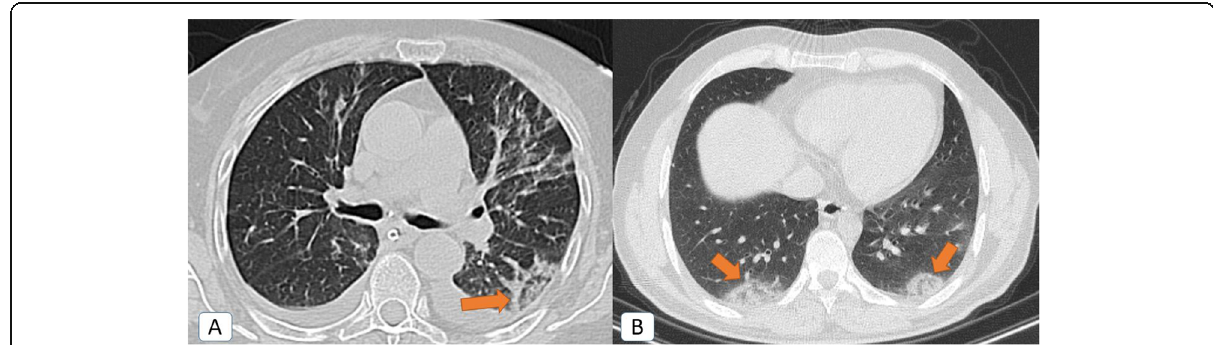
Fig. 6 Bulls-eye sign or target sign or double-halo sign: a 36-year-old male COVID-19 patient. A , B Axial chest CT (lung window) showing bilateral posterior basal sub-pleural patches of central and peripheral consolidations with intervening ground-glass attenuation. This is together with bilateral minimal pleural collection and left lingular mild fibro-atelectatic